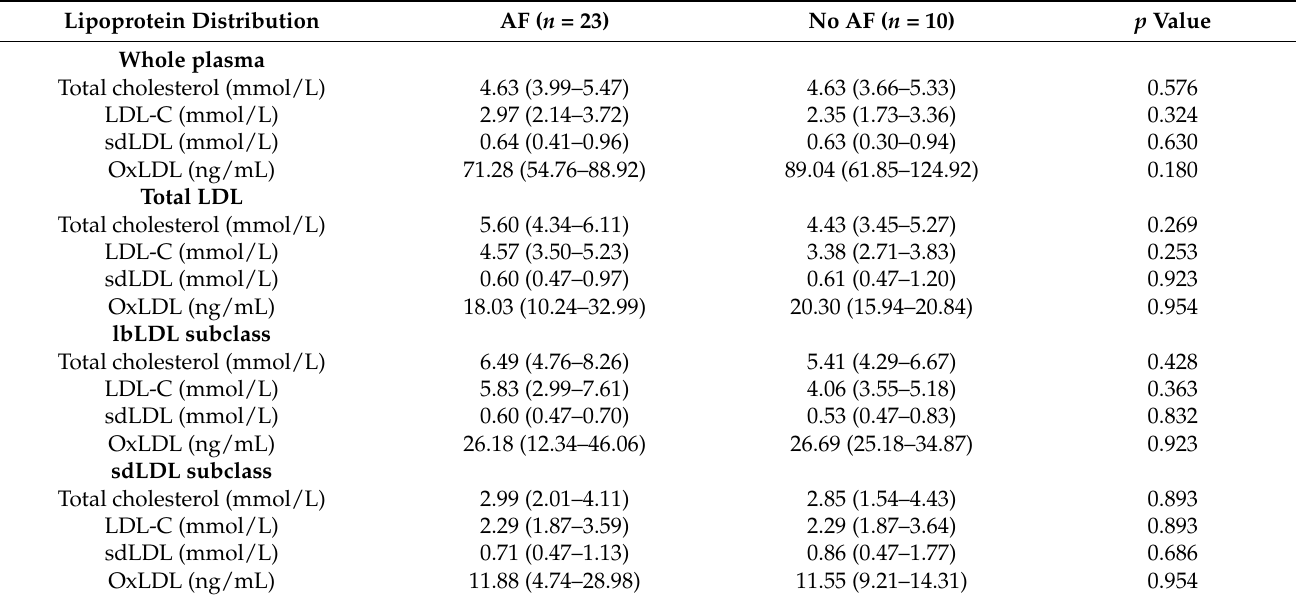
Table 5. Lipoprotein distribution of patients with and without atrial fibrillation.